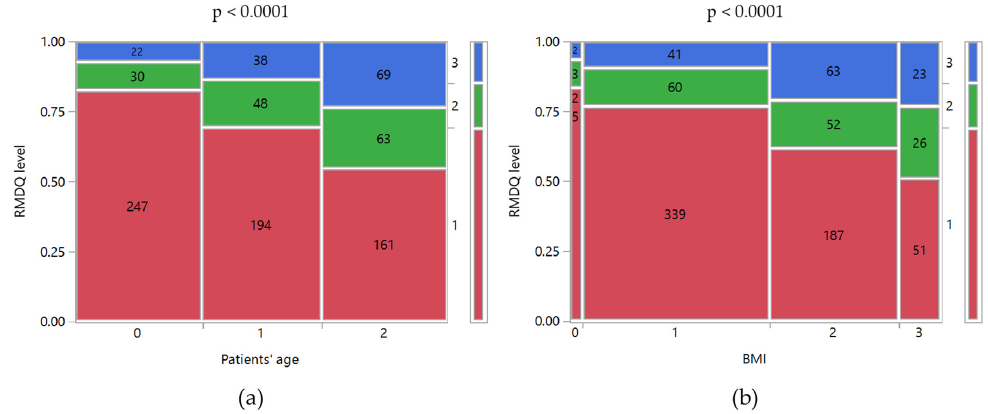
Figure 2. Mosaic plots of RMDQ level versus ( a ) Patient’s age and ( b ) BMI. RMDQ levels: 1, low; 2, medium; 3, high. Patients’ age levels: 0, < 40 years old; 1, 40–52 years old; 2, > 52 years old. BMI levels: 0, underweight; 1, normal weight; 2, overweight; 3, obese. The class counts were reported inside the